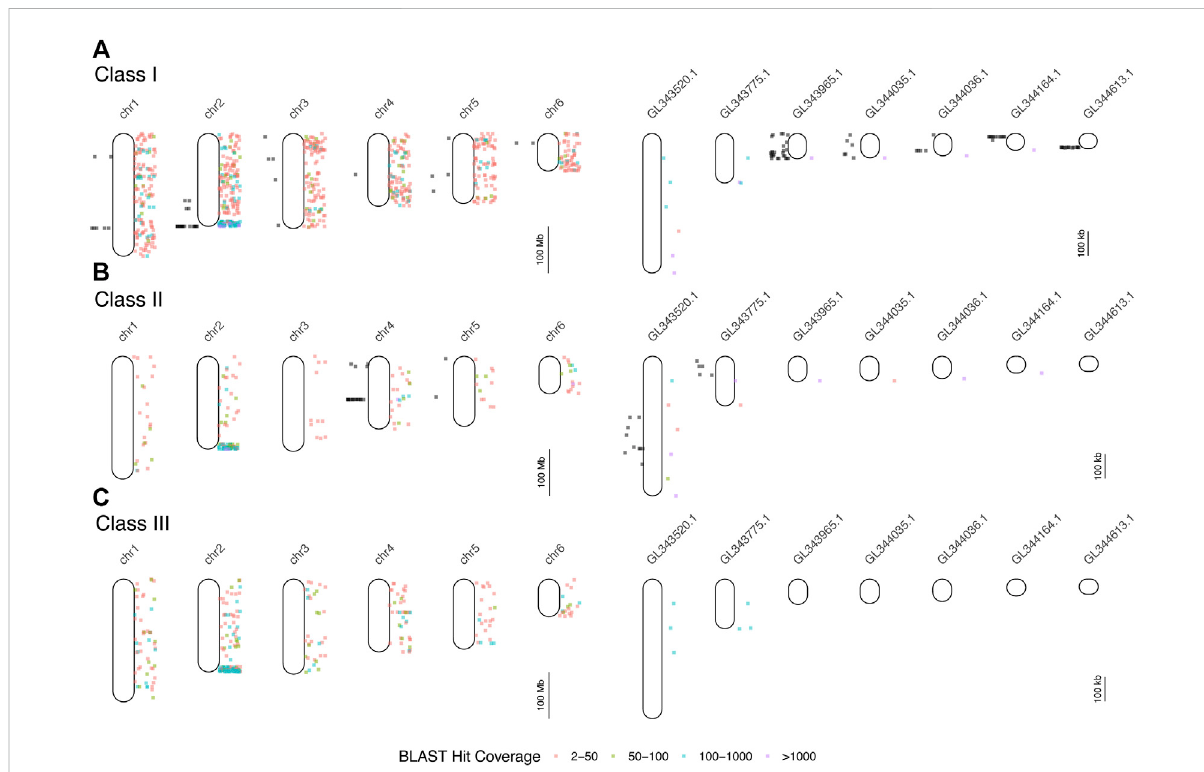
FIGURE 2 ResultsofmappingofBACendsequences(BESs)ofBACsdetectedinhybridizations(blackdotstotheleftofeachchromosomeorscaffold)and BLAST searches of human and mouse MHC protein data to the green anole genome (colored dots to the right). Each point indicates the locations of BLAST hits (binned by hit coverage). Results are displayed separately for class I (A) , class II (B) , and class III (C) genes for all six chromosomes and for unplaced scaffolds with fi ve or more mapped BESs. Note differences in scale between panels devoted to chromosomes (left column) and unplaced scaffolds (right column). See Supplementary Table S6 for the results of the BLAST mapping of